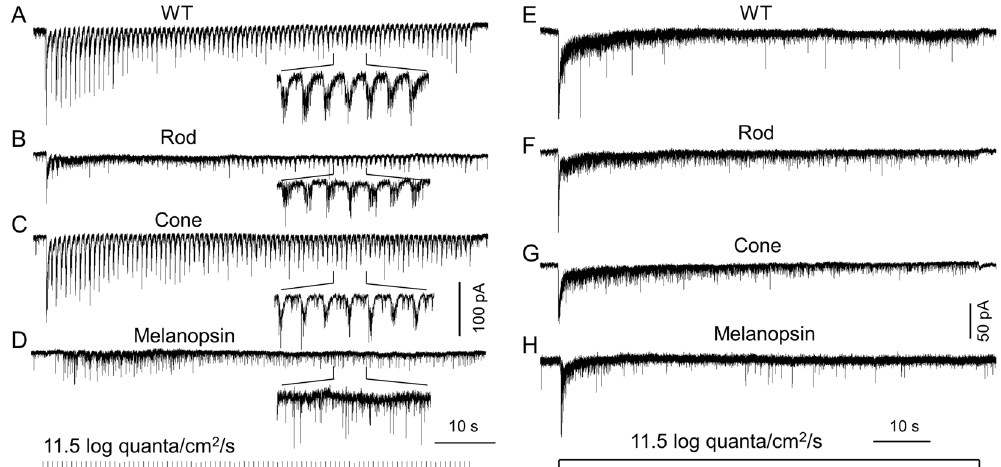
Figure 6. Rods, M-cones and melanopsin contribute to DAC responses to intermediate background light. ( A – D ) An 100 ms-duration, 0.75 Hz flashing light with an intensity of 11.5 log quanta/cm 2 /s was applied to the retina for 2 min. ( A ) Repetitive responses were obtained from a dorsal DAC in a wild-type retina. The indicated portion of the trace is time-expanded. ( B ) Rod-mediated responses of a DAC were recorded in the presence of TTX in a cone-function-knockout retina. The initial 3 pulses produced individual responses, after which the cell exhibited a steady-state inward current. The repetitive responses reappeared after approximately 40 s and continued until the stimulus was terminated. The indicated portion of trace is time-expanded. ( C ) Repetitive responses were obtained from a dorsal DAC in a cone-function-only retina. The indicated portion of trace is time-expanded. ( D ) The repetitive light pulses produced a barrage of melanopsin-based miniature EPSC events in a DAC. The cell was recorded in a wild-type retina in the presence of 50 µ M L-AP4. The indicated portion of trace is time-expanded. A series of tick marks at the bottom of the figure indicate the pattern of light stimuli. ( E – H ) Steady background illumination with an intensity of 11.5 log quanta/cm 2 /s was applied to the retina for 2 min. A WT DAC had an initial inward current to the steady background light ( E ). The current slowly decayed toward the baseline. The same dynamic was observed in a rod-mediated DAC response ( F ), a M-cone-mediated response ( G ), and a melanopsin-based response ( H ). Stimulation bar shows timing of light